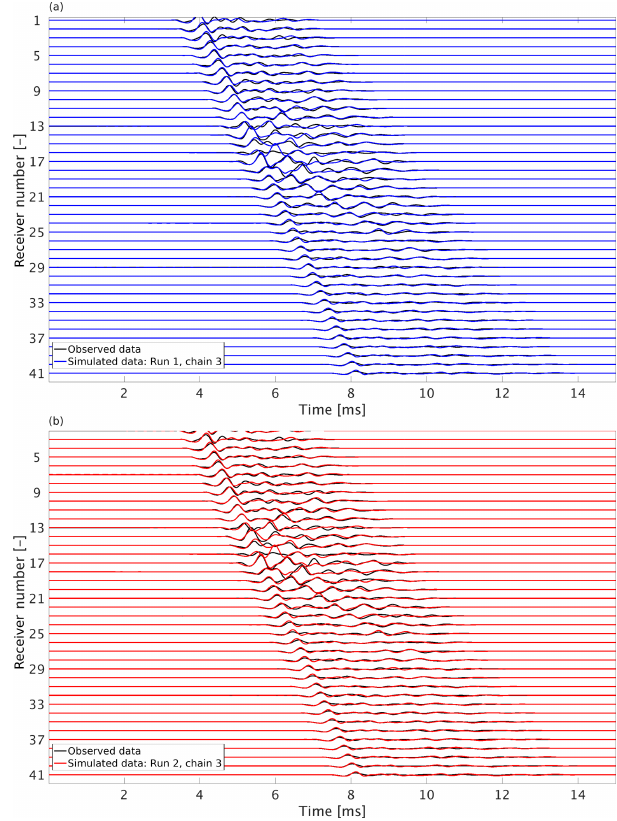
Figure 6. Comparison between simulated (colored) and observed (black) data: (a) run one and (b) run